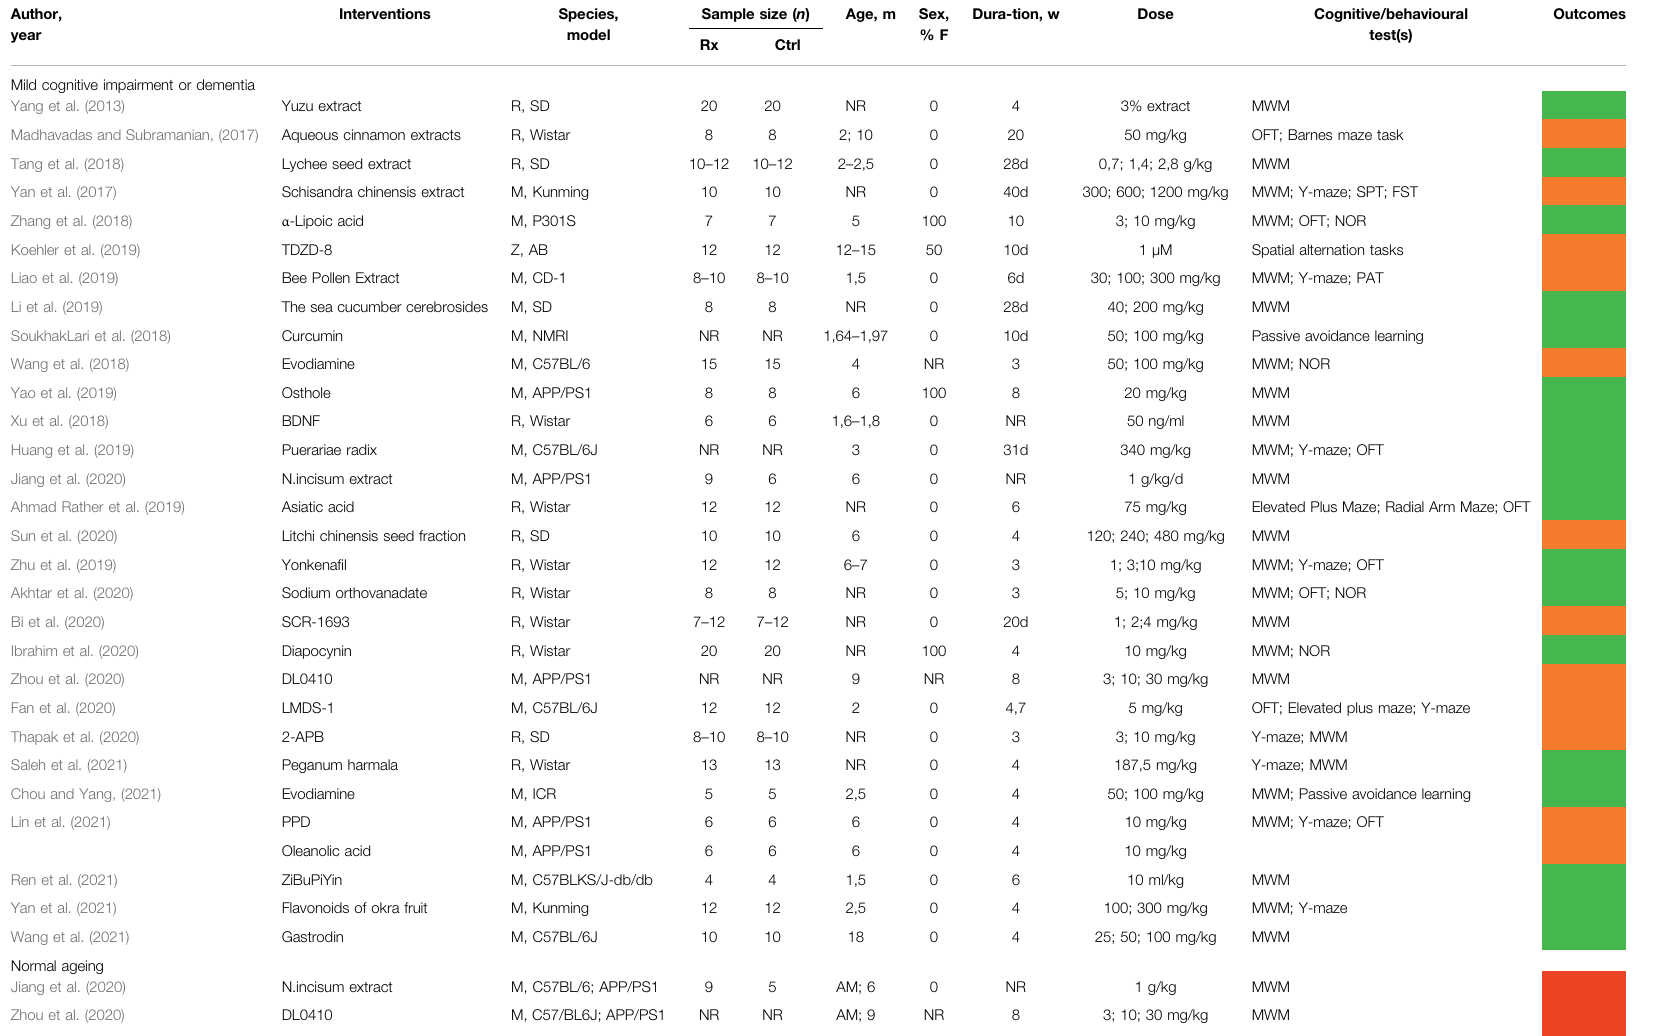
TABLE 1 | Characteristics of studies testing the effect of compounds interfering with the GSK3 pathway on